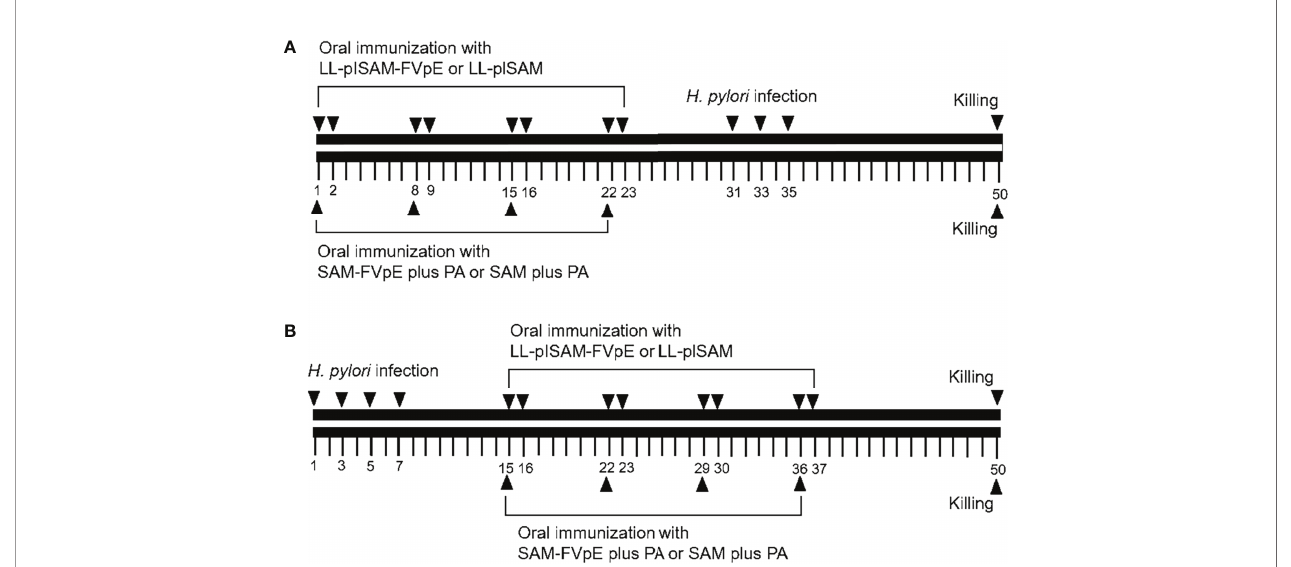
FIGURE 1 | Schematicrepresentation of prophylacticand therapeutic immunization. (A) Prophylacticimmunization. Mice were administered orally with LL-plSAM-FVpE andLL-plSAM.Moreover,mice were also orally vaccinated with SAM-FVpEor SAM in500 m l PA adjuvant. After oral vaccination,micewere challenged with ( H ) pylori on designated days. (B) Therapeuticimmunization. ( H ) pylori -infectedmicewere divided into 4 groups(n=10). Mice were orallyvaccinatedwith LL-plSAM-FVpEorLL-plSAM (3 × 10 9 CFU) respectively. Mice were also orally immunized with 100 m g of SAM-FVpE or SAM in500 m l PA adjuvant. On day 50, the mice were